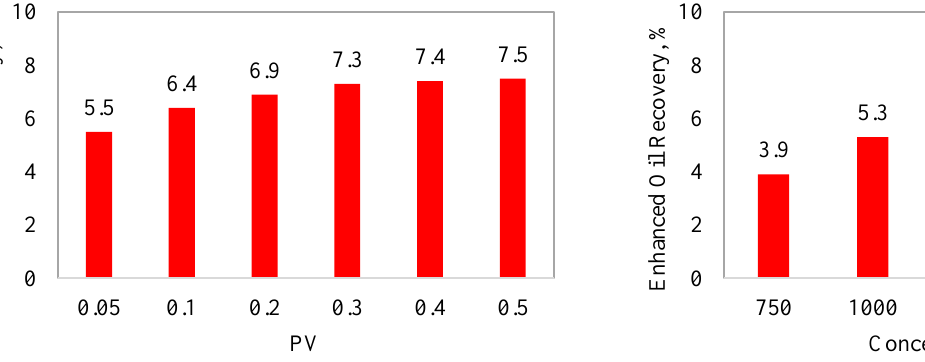
Figure 10—Numerical simulation of the effect of polymer concentration on oil recovery.